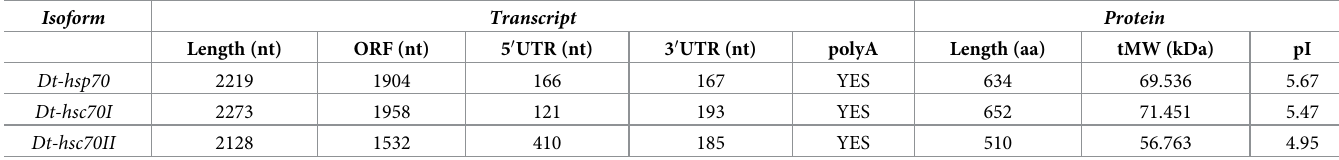
Table 2. Summary of the characteristics of all sequences and their deduced proteins. Isoform Transcript Protein Length (nt) ORF (nt) 5 0 UTR (nt) 3 0 UTR (nt) polyA Length (aa) tMW (kDa) pI Dt-hsp70 2219 1904 166 167 69.536 5.67 Dt-hsc70I 2273 1958 121 193 5.47 Dt-hsc70II 2128 1532 410 185 YES 510 56.763 4.95 ORF = Open Reading Frame; UTR = Un-Translated Region; tMW = theoretical Molecular